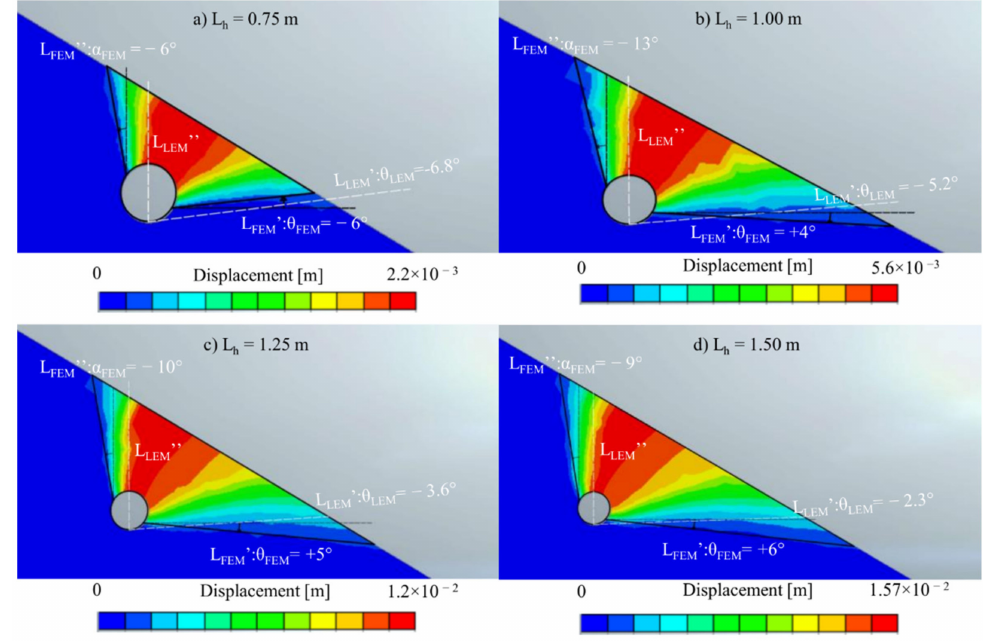
Figure 7. Comparison between FEM and LEM failure kinematics for different values of L h : ( a ) L h = 0.75 m, ( b ) L h = 1.00 m, ( c ) L h = 1.25 m, ( d ) L h = 1.50 m ( D = 0.25 m, γ = 18 kN/m 3 , c = 3 kPa, φ = 31 ◦ , β = 30 ◦